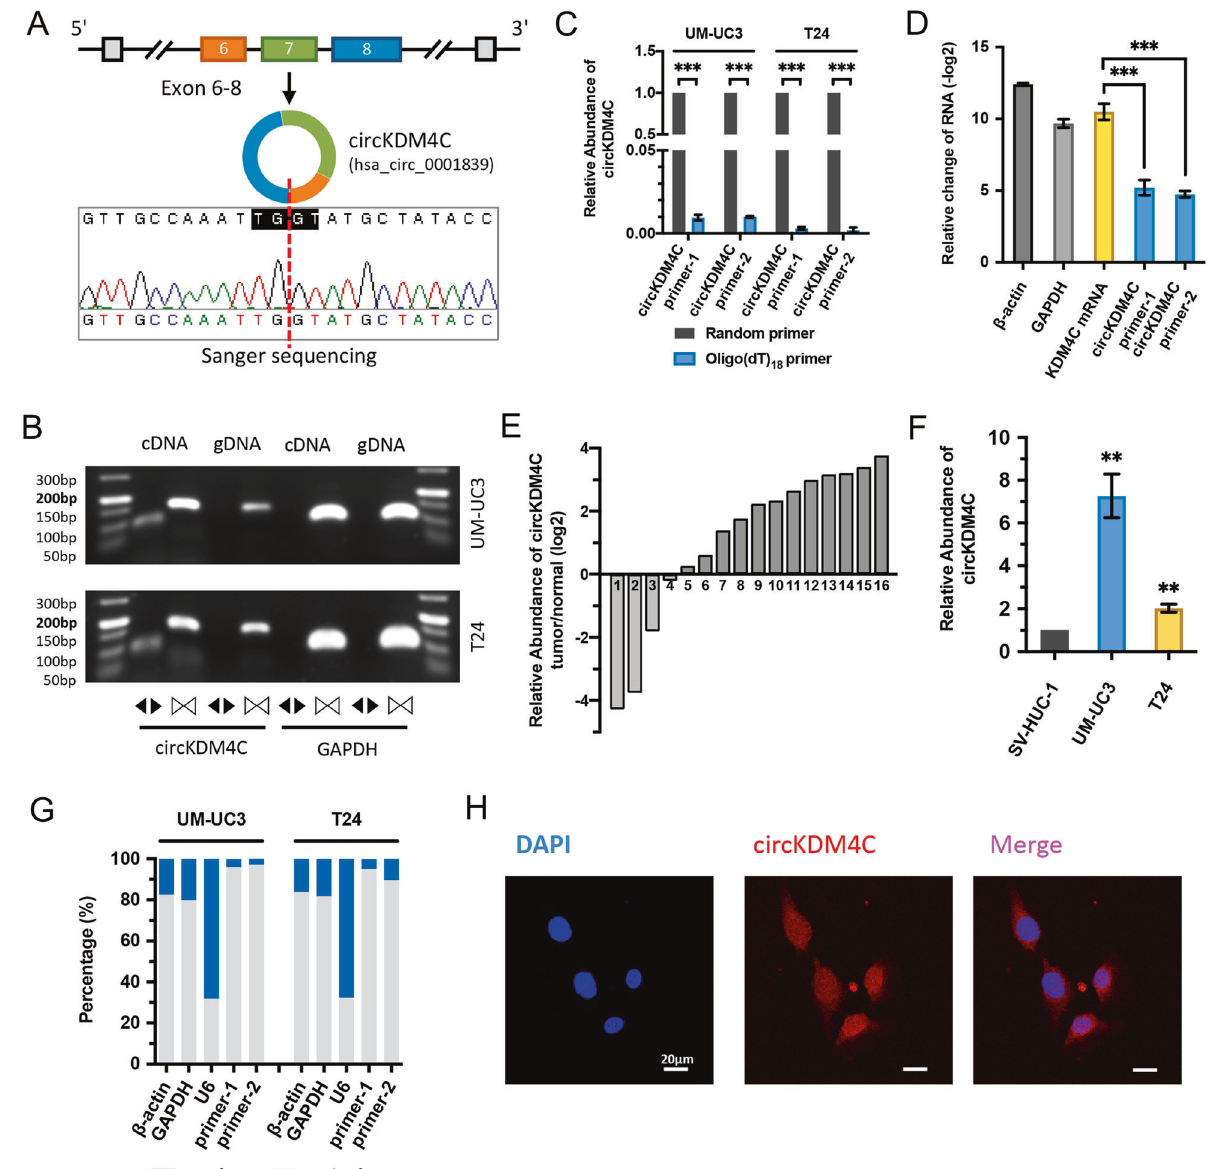
Fig. 1 Identi fi cation of circKDM4C and its expression in BCa tissues and cell lines. A Schematic illustration shows the circularization of KDM4C exon 6 – 8 formed circKDM4C. Sanger sequencing was used to identify the circKDM4C back-splice junction. Red dashed line indicates the back-splicing site. B The existence of circKDM4C was con fi rmed in UM-UC3 and T24 cells by PCR and agarose-gel electrophoresis. Divergent primers could amplify circKDM4C in cDNA, but not in gDNA. GAPDH (105 bp) was the linear control. circKDM4C, 93 bp; KDM4C mRNA, 158 bp. C qRT-PCR analysis of circKDM4C in the cDNA constructed by random primers or oligo-dT primers. circKDM4C level was evaluated by two pairs of divergent primers. D circKDM4C and KDM4C mRNA levels after treatment with or without RNase R in UM-UC3 cells. E The expression of circKDM4C in 16 pairs of BCa tissues and adjacent normal tissues was determined by qRT-PCR. F circKDM4C levels in normal uroepithelium cell line (SV-HUC-1) and cancer cell lines (UMUC-3 and T24). G circKDM4C levels in nuclear and cytoplasmic fractions of UM-UC3 and T24 cells. H RNA FISH assay showed that circKDM4C was mainly located in the cytoplasm in T24 cells (circKDM4C probe was Cy3- labeled, the nuclei were DAPI-stained). Scale bar = 20 μ m. Data are expressed as the means ± SD for n = 3. ** P < 0.01; *** P < suggesting that circKDM4C was depleted in poly (A)-enriched pairs of divergent primers for detecting circKDM4C. Then, through samples (Fig. 1C). Moreover, circKDM4C was con fi rmed to be far Sanger sequencing, we veri fi ed the head-to-tail splicing of more resistant to RNase R treatment than linear KDM4C mRNA circKDM4C in the expected-size PCR product by Sanger sequen- (Fig. 1D). cing (Fig. 1A). However, head-to-tail splicing might be attributed to reverse-transcriptase template switching, trans-splicing, or genomic rearrangements. Therefore, we designed convergent primers for amplifying KDM4C mRNA. The results showed that circKDM4C could only be detected by divergent primers in cDNA, but not in gDNA (Fig. 1B). In addition, circKDM4C was almost undetectable in cDNA constructed using oligo-dT primers,